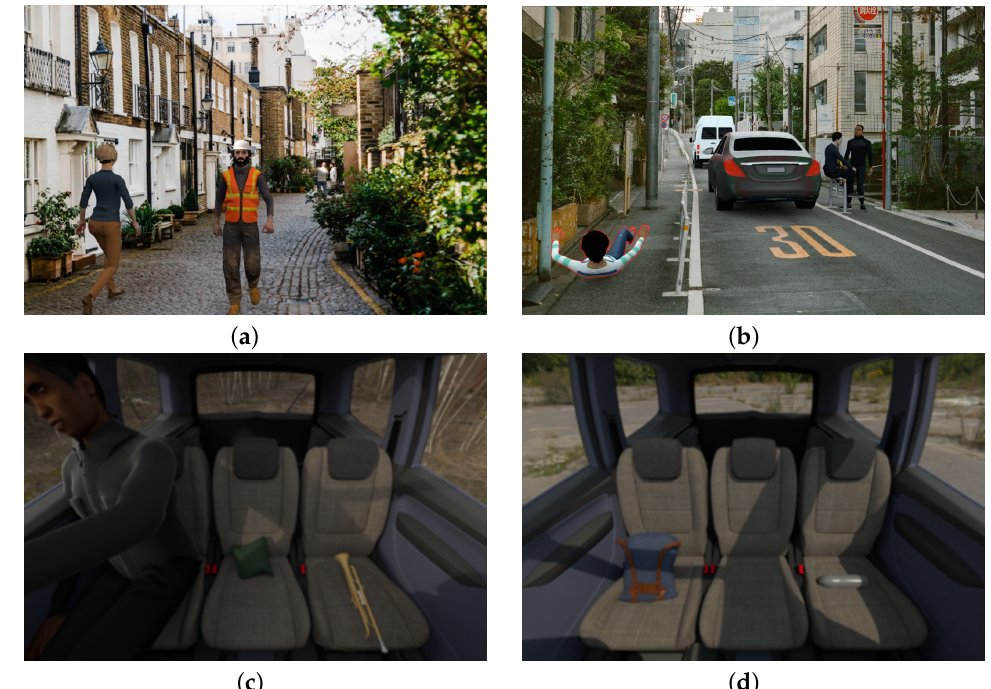
Figure 5. Comparison between normal and abnormal frames extracted from synthetic datasets.